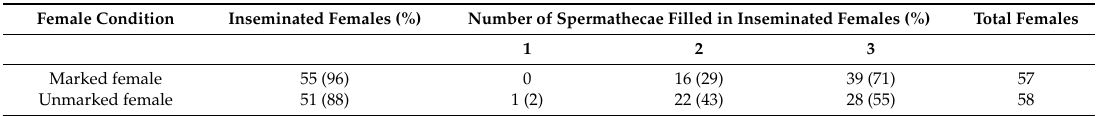
Table 2. Inseminated females and spermathecae filled in marked and unmarked inseminated females after being exposed to males able to choose their mating